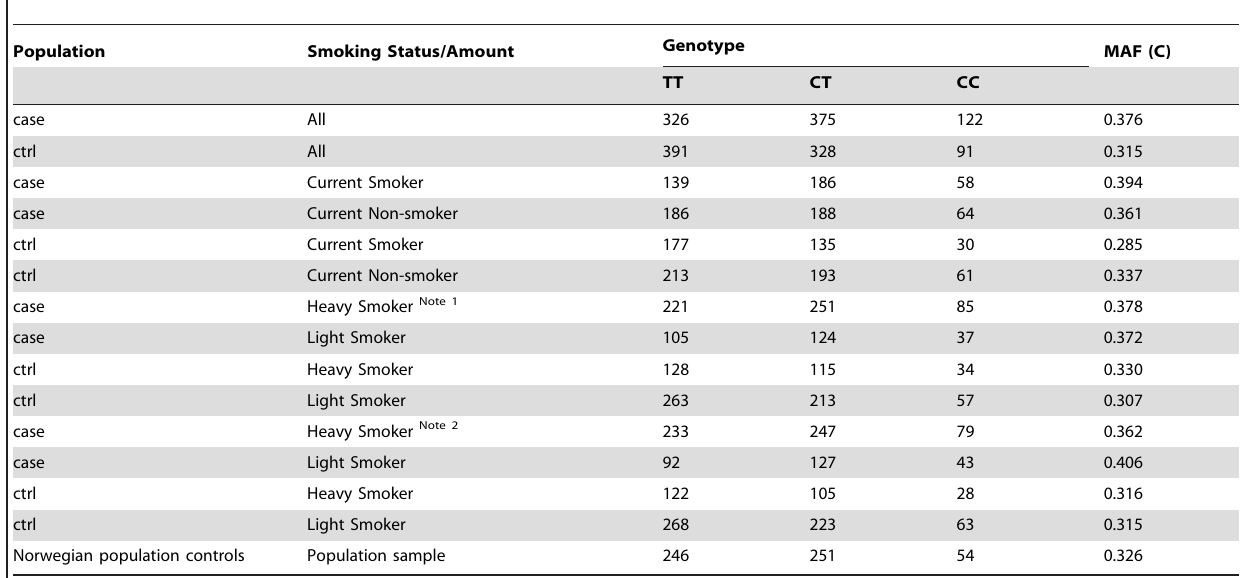
Table 3. Genotype counts and allele frequencies for rs8034191 by case-control status and smoking status in the Bergen discovery